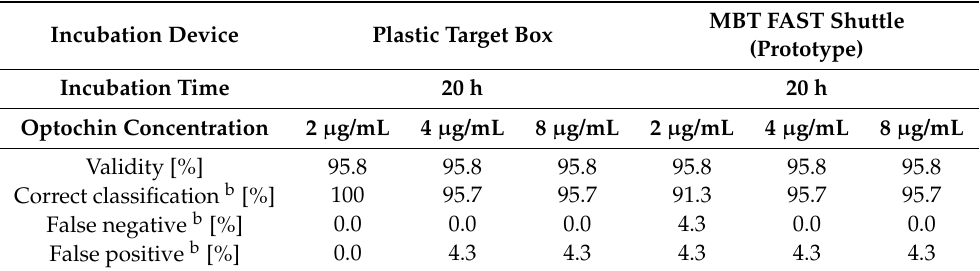
a test set isolates, n = 24; b Calculated for valid tests.